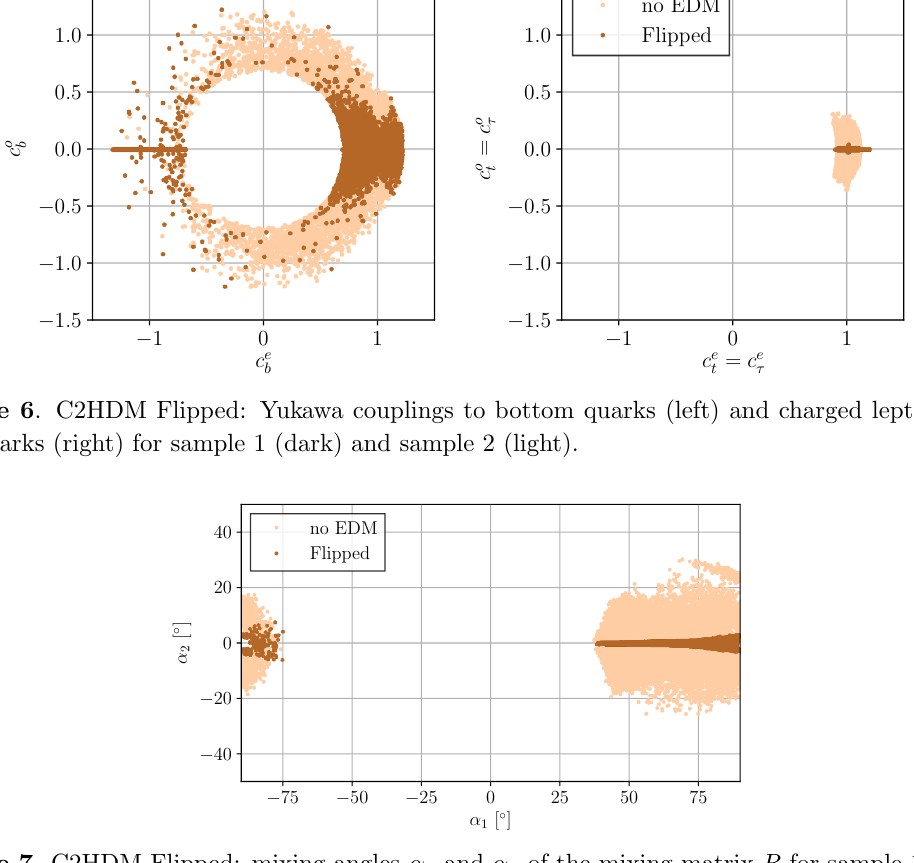
and (cid:11) of the mixing matrix R for sample 1 (dark) 1 2